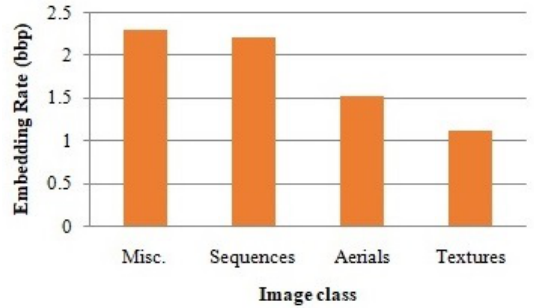
Figure 8. Embedding rate obtained from natural image classes.